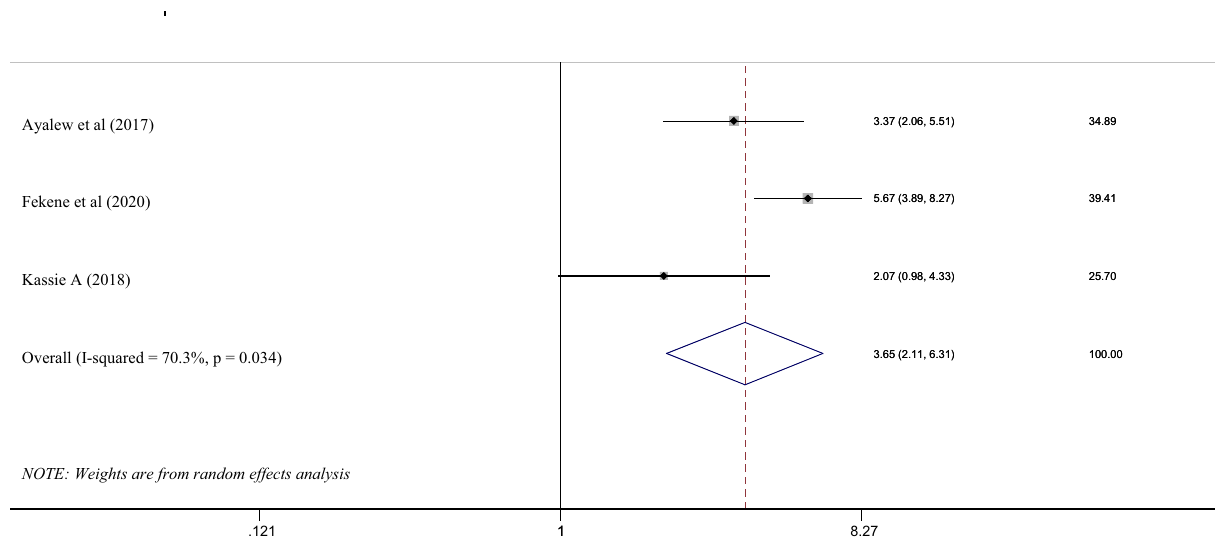
Figure 4. Shows the effects of family planning utilization on women’s preconception knowledge in